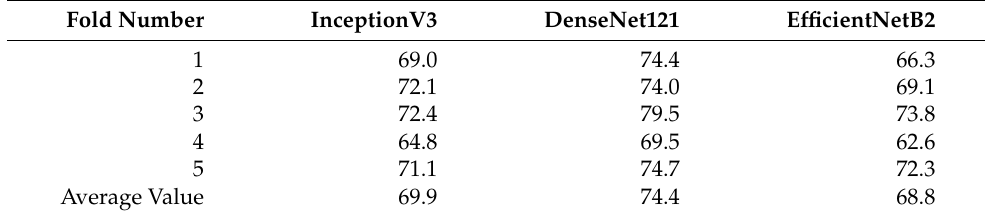
Table 8. Validation accuracy of single Chinese phrase multi-category classification.